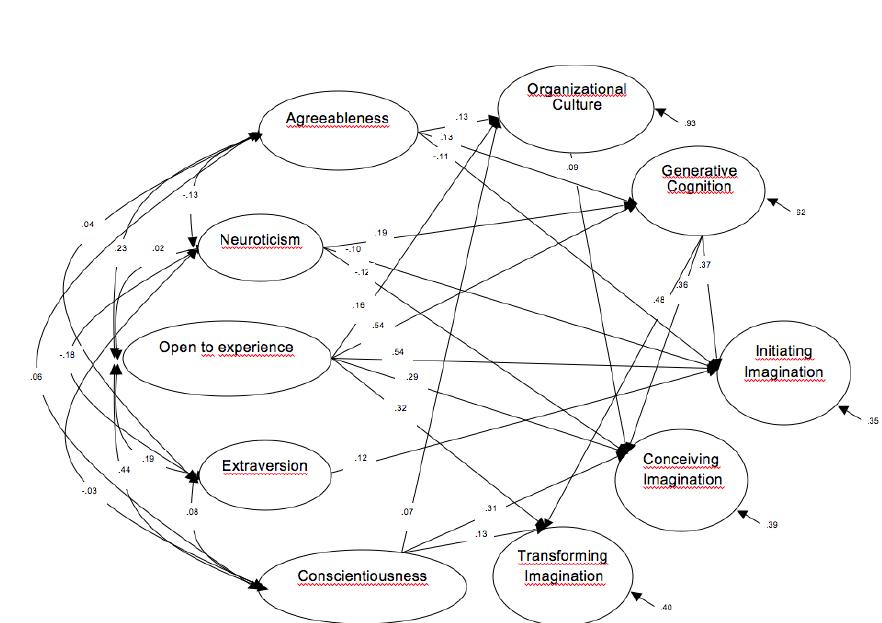
Figure 1 . The mediation model of the imagination (n = 473) Our results show that, in addition to the mediators, openness proved to be the most influential factor, which affected the three types of imagination. Extraversion was the second most influential predictor of initiating imagination, whereas conscientiousness was the second most influential predictor of both conceiving and transforming imagination. The direct and indirect effects resulting from all the latent predictor variables on the three types of imagination are reported in Table